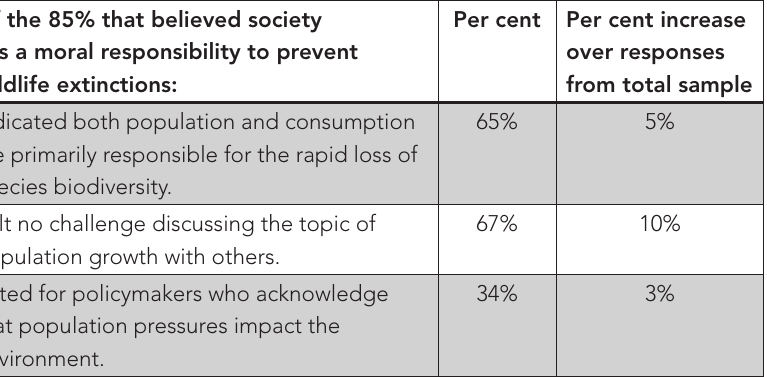
Table 1: Norms/Morality Crosstab Results Of the 85% that believed society has a moral responsibility to prevent wildlife extinctions: Indicated both population and consumption are primarily responsible for the rapid loss of species biodiversity. Felt no challenge discussing the topic of population growth with others. Voted for policymakers who acknowledge that population pressures impact the